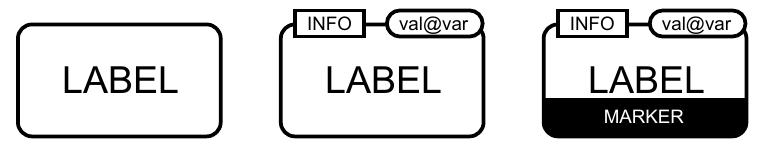
Figure 2.12: The Process Description glyph for macromolecule , shown plain and unadorned on the left, with an additional state variable and a unit of information in the middle, and with a labelled clone marker on the